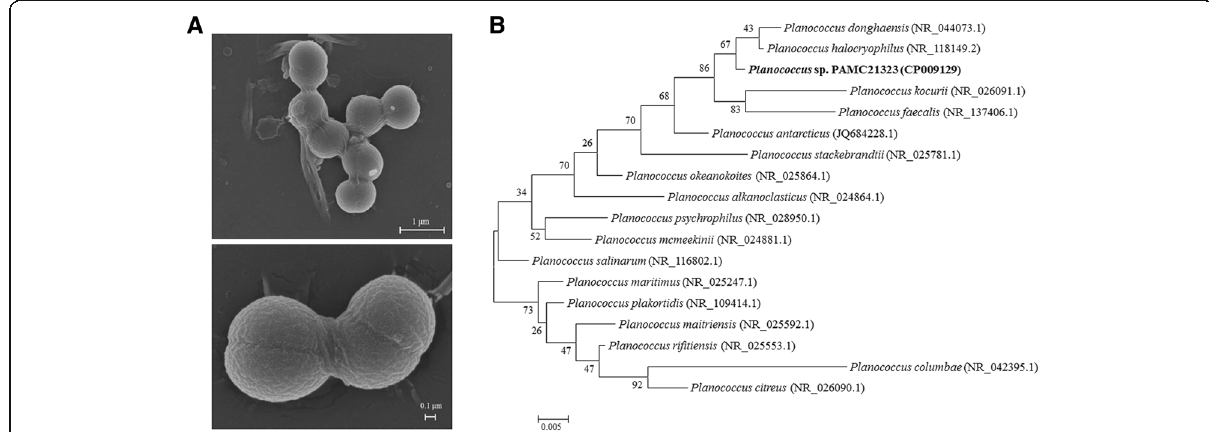
Fig. 1 Scanning electron micrograph of Planococcus sp. PAMC21323 ( a ) and Phylogenetic analysis of Planococcus sp. PAMC21323 relative to nearest-neighboring Planococcus type strains ( b ): The 16 s sequences were obtained from the NCBI database and aligned using ClustalOmega. Phylogenetic tree constructed with the Maximum-Likelihood algorithm of MEGA 6.0. Bootstrap values were determined from 1000